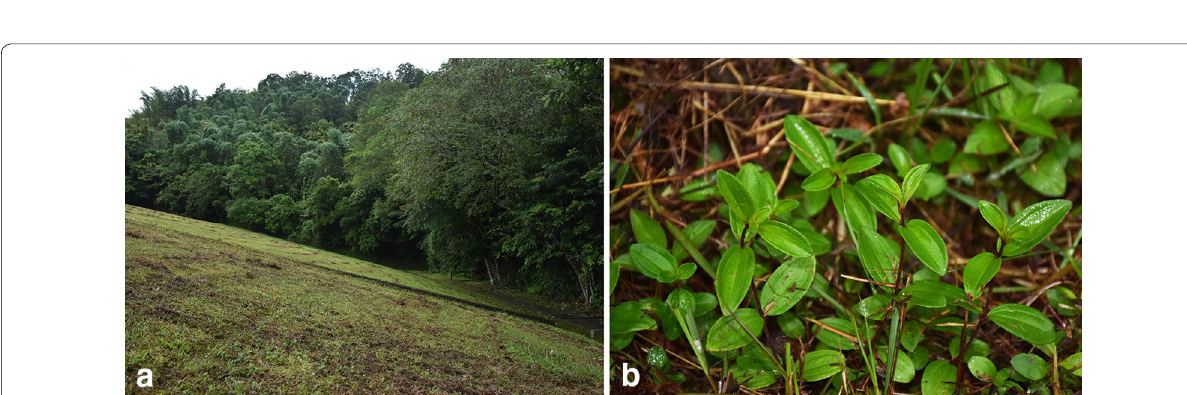
(Fig. 7b), remotely strigose, petiole 2 mm long. Termi-